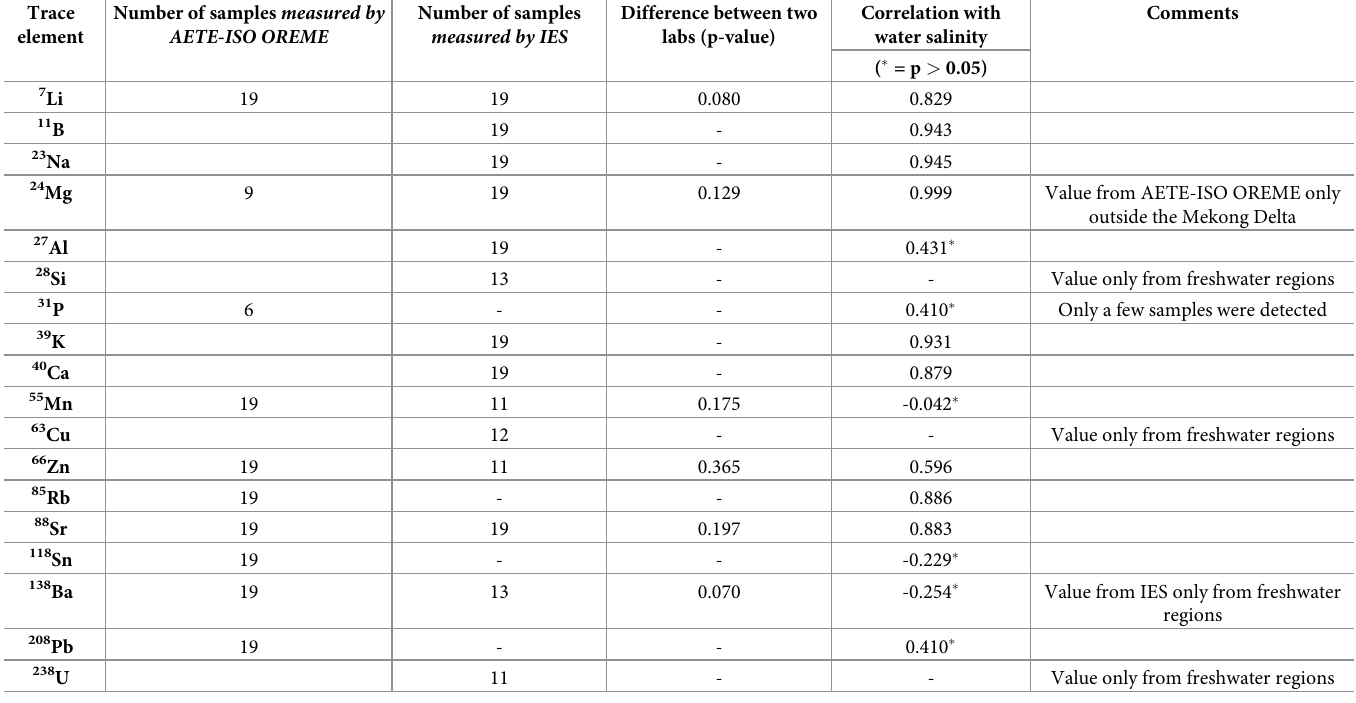
Table 3. Trace element concentrations measured by the two laboratories (AETE-ISO OREME and IES). Trace element